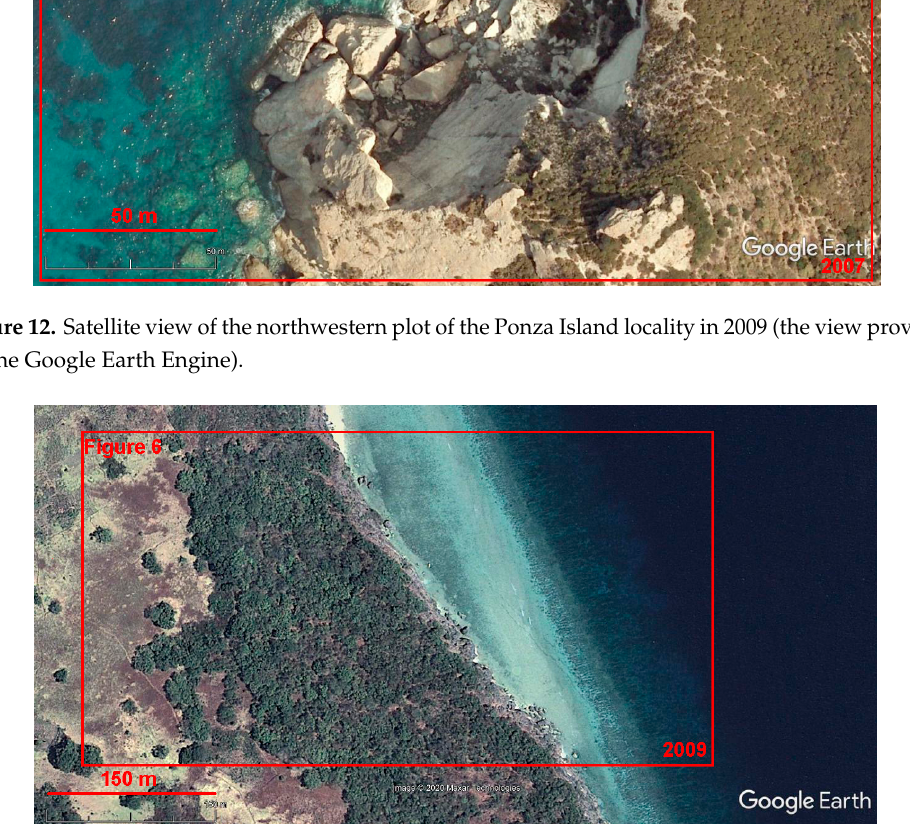
Figure 13. Satellite view of the eastern plot of the Wetar Island locality in 2007 (the view provided by the Google Earth Engine).